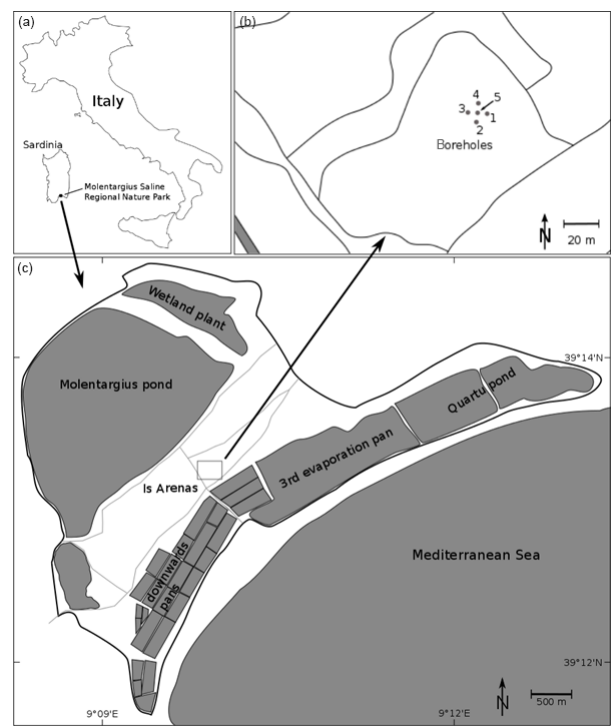
Figure 1. Geographical location of the test site: (a) Molentargius Saline Regional Nature Park located East of Cagliari in southern Sardinia, Italy, (b) Detailed sketch map of location and arrangement of the boreholes, (c) Sketch map of the Molentargius Park (modified according to Google